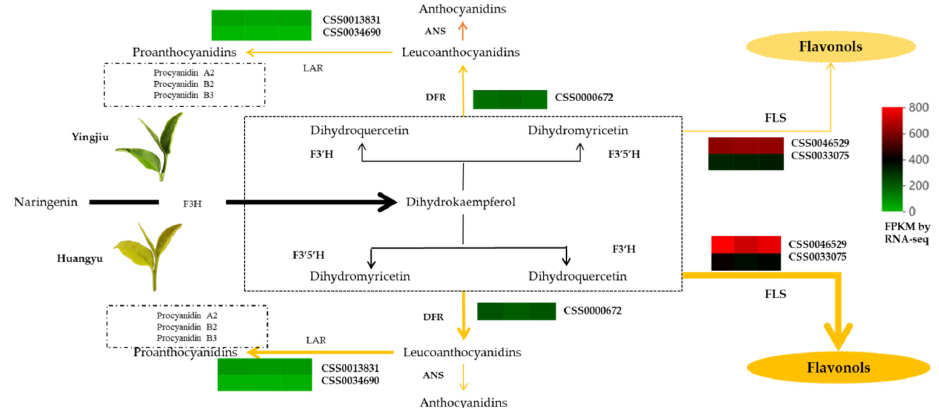
Figure 7. DEGs involved in flavonoid pathway and expression levels in ‘Yinghong 9’ and ‘Huangyu’. The heatmap is created according to the average expression levels of related biosynthetic genes based on the FPKM value by RNA-seq. Green indicates low expression levels, and red indicates high expression levels. ANS, anthocyanidin synthase; DFR, dihydroflavonol reductase; F3 ′ 5 ′ H, flavonoid 3 ′ ,5 ′ -hydroxylase; F3H, flavanone-3-hydroxylase; F3 ′ H, flavonoid 3 ′ -hydroxylase; FLS, flavonol synthase; LAR, leucoanthocyanidin reductase. Heavy lines indicate the enhancement of metabolic flux in ‘Huangyu’, and thin lines indicate the attenuation of metabolic flux in ‘Yinghong 9’.